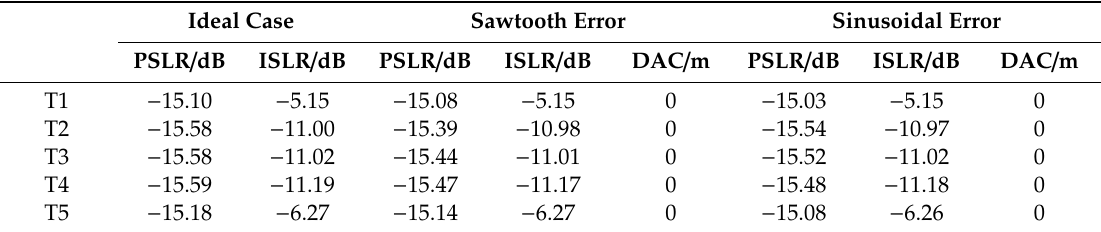
Table 2. Quality parameters with the sway. Note: PSLR = peak sidelobe level ratio; ISLR = integral sidelobe level ratio; DAC = deviation of along-track coordinates.